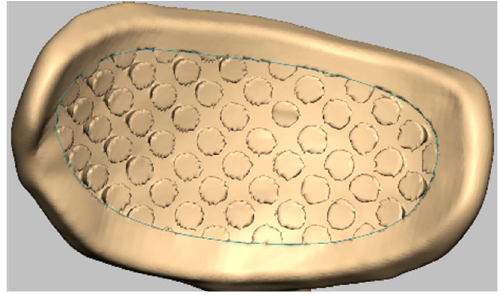
Figure 1. Undercut-modified adhesive surface.